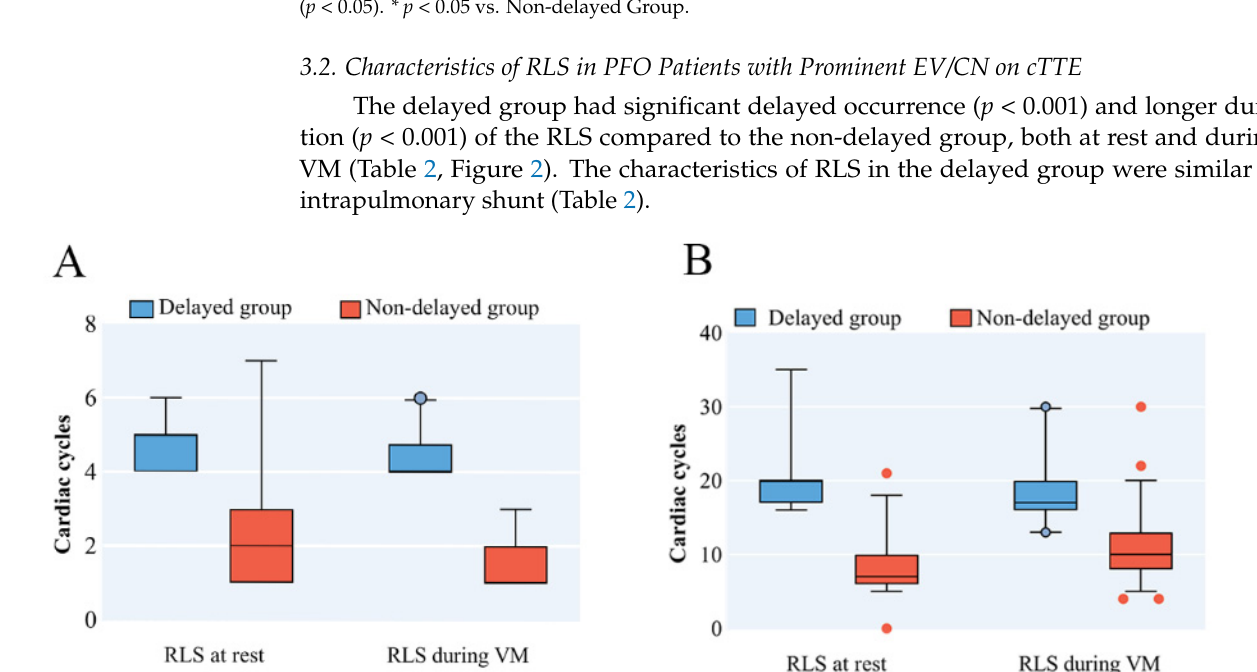
Figure 2. Characteristics of RLS in PFO patients with prominent EV/CN on cTTE. The delayed group had significant delayed occurrence ( A ) and longer duration ( B ) of the RLS compared to the non-delayed group, both at rest and during VM. CN = Chiari Network; cTTE = contrast transthoracic echocardiography; EV = Eustachian valve; PFO = patent foramen ovale; RLS = right-to-left shunt; VM= Valsalva maneuver.